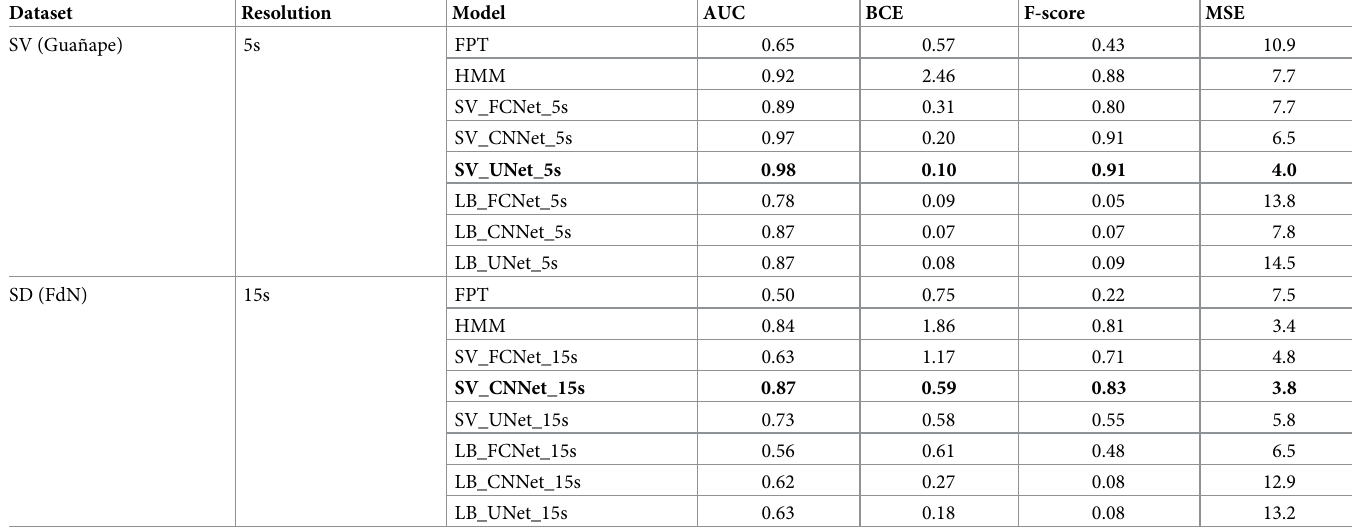
Table 3. Deep network testing. The deep networks fitted on the dataset from Pescadores have been used for dive prediction in Gua ñ ape and in Fernando de Noronha. Deep networks are described by their reference name (see Table 2).